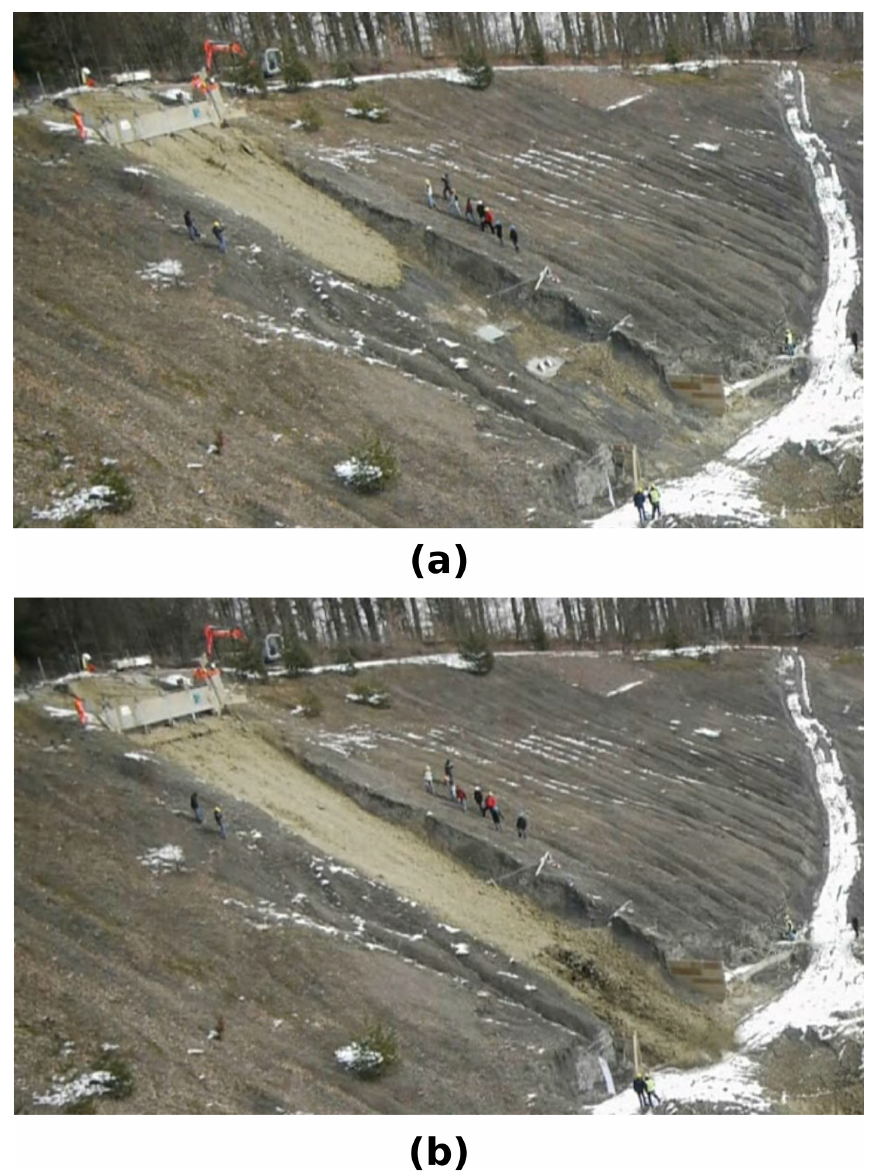
Figure 3. Screenshots of test 10: 3s after release (a) and 6s after release (b)